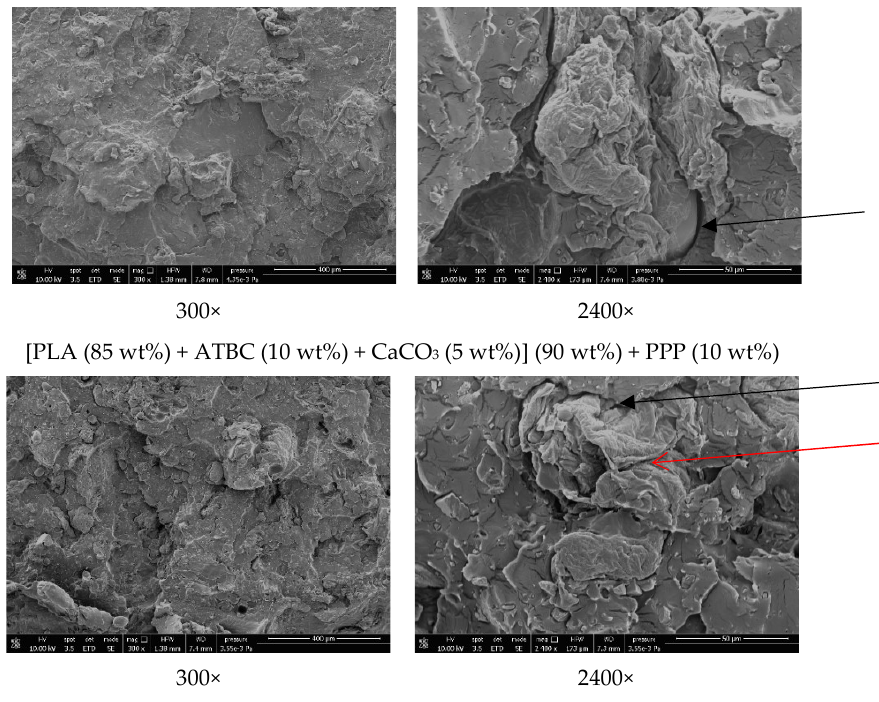
Figure 9. SEM images of the [PLA (85 wt%) + ATBC (10 wt%) + CaCO 3 (5 wt%)] (90 wt%) + PPP (10 wt%) and [PLA (85 wt%) + ATBC (10 wt%) + CaCO 3 (5 wt%)] (80 wt%) + PPP (20 wt%) biocomposite at the indicated magnification.